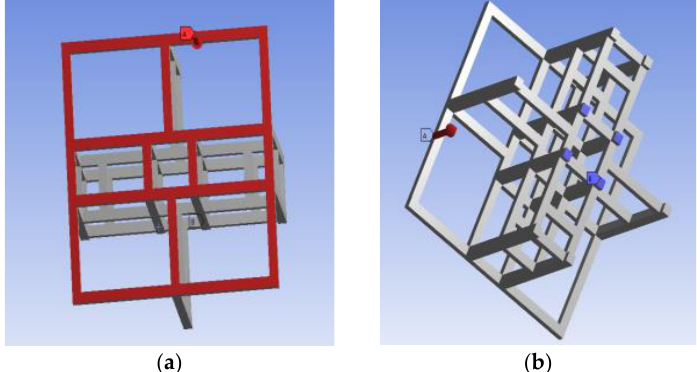
Figure 3. Model of the loading surface and constraint points of the benthic lander: ( a ) benthic lander loading surface; ( b ) benthic lander constraint point.